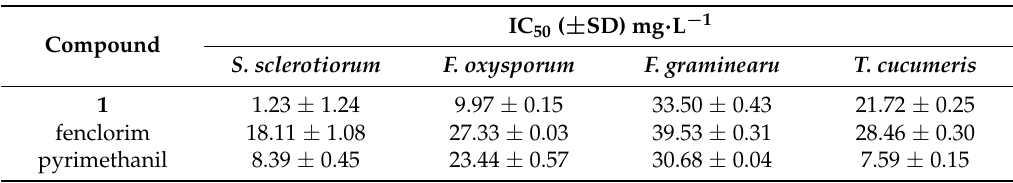
Table 5. IC 50 values of Compound 1 , fenclorim and pyrimethanil against Sclerotinia sclerotiorum , Fusarium oxysporum , Fusarium graminearum , and Thanatephorus cucumeris 1